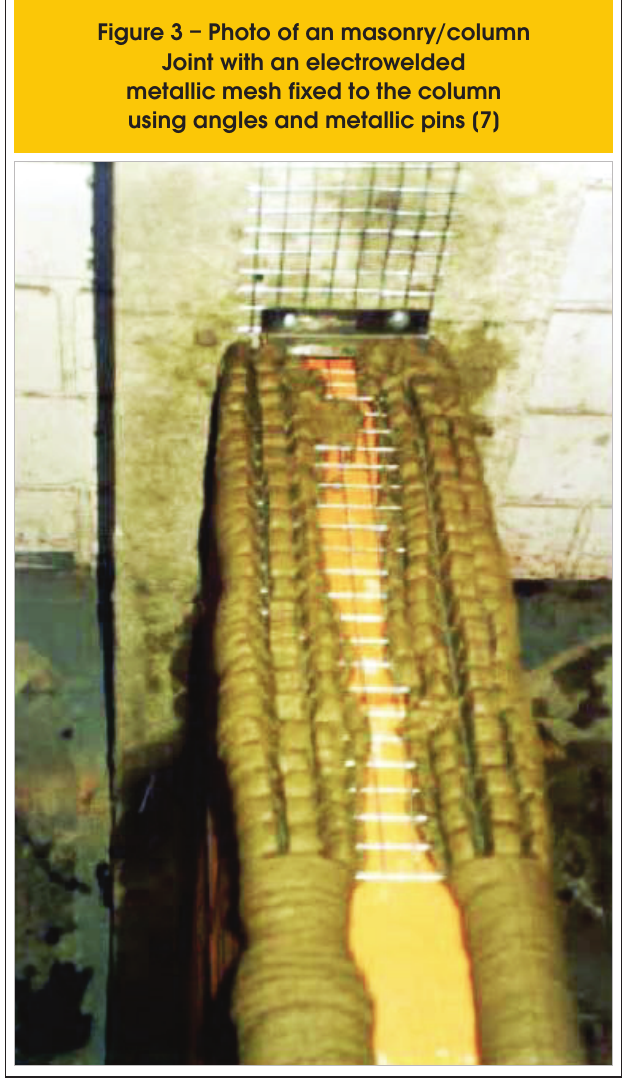
Figure 3 – Photo of an masonry/column Joint with an electrowelded metallic mesh fixed to the column using angles and metallic pins